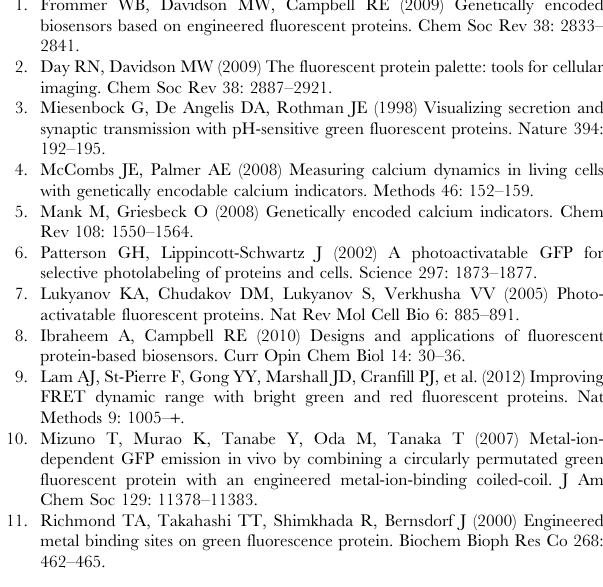
were the same as the single iq-FPs (432 nm for Emerald and 517 nm for mApple in this example). (TIF) Figure S10 Plot of the distances between FRET donor (chromophores of iq-FPs) and acceptors (metal ions) pairs, calculated from FRET measurements. The dotted lines are the reference distances measured from the nickel-bound iq-mEmerald crystal structure. In this crystal structure, the distance between the nickel ion to the closest and furthest atom on the chromophore are 10.8 and 20.3 A˚ , respectively. Despite comparing different FP and metal types, most of the FRET calculated distances are within the range that the crystal structure indicated. (TIF) Table S1 The spectrally calculated R 0 and distances calculated from FRET measurements for each iq-FP/ metal pair. (PDF) Table S2 Data collection and refinement statistics of the iq-mEmerald crystal structures. (PDF) Table S3 The dynamic range and relative fluorescence ratio change (R max /R min ) in three ratiometric